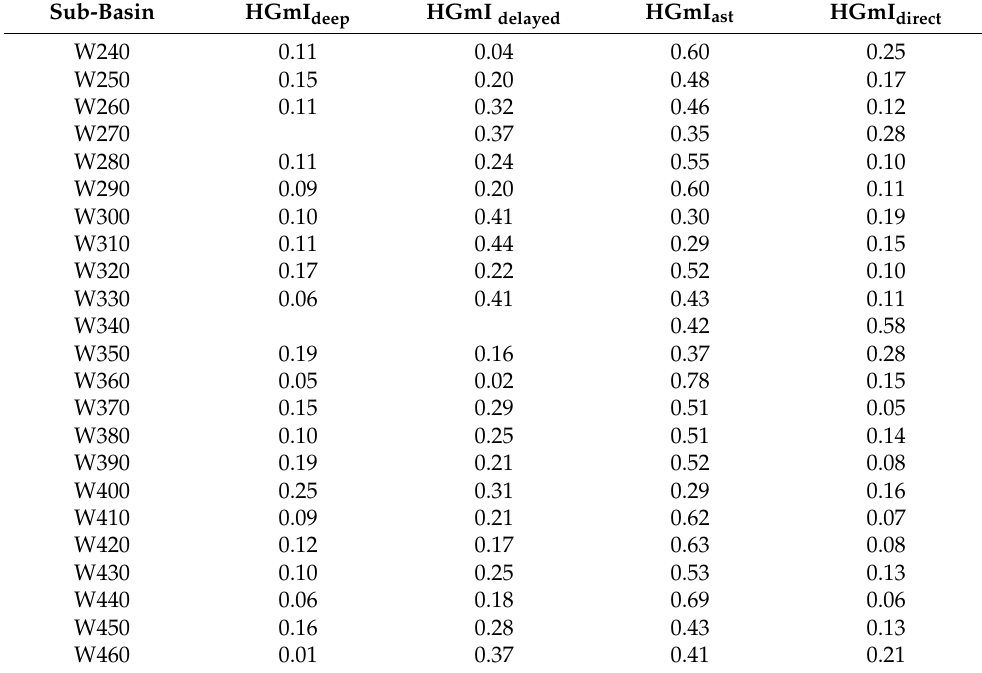
Table 7. HGmI evaluated at the outlet of Ciciriello’s sub-basins for each component (deep percolation, delayed and fast return flow, and direct